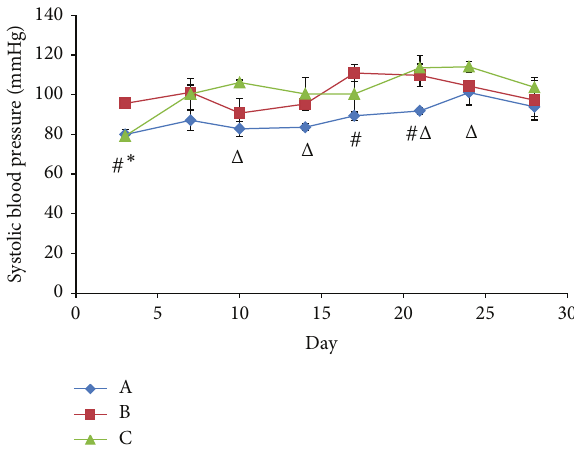
Figure 3: Mean systolic blood pressure of rats in each group across the four-week period, measured twice a week for each rat. # depicts a significant difference between Group A and B, Δ depicts a significant difference between groups A and C, and ∗ indicates a significant difference between groups B and C (significant difference indicated by 𝑃 < 0.05 ). Group A: control (HSD/HFD); group B: stress + HSD/HFD; group C: stress + GA + HSD/HFD. Abbreviations: GA: glycyrrhizic acid, HSD: high-sucrose diet, and HFD: high-fat